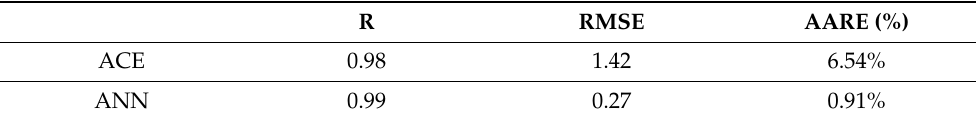
Figure 11. Correlation between the experimental and modeled flow stresses obtained by ( a ) ACE and ( b ) ANN models. Table 4. Performance indicators the correlation coefficient (R), average absolute relative error (AARE) (%), and root means square error (RMSE) values of the proposed models after fitting and approxima- tion of the flow behavior for the alloy